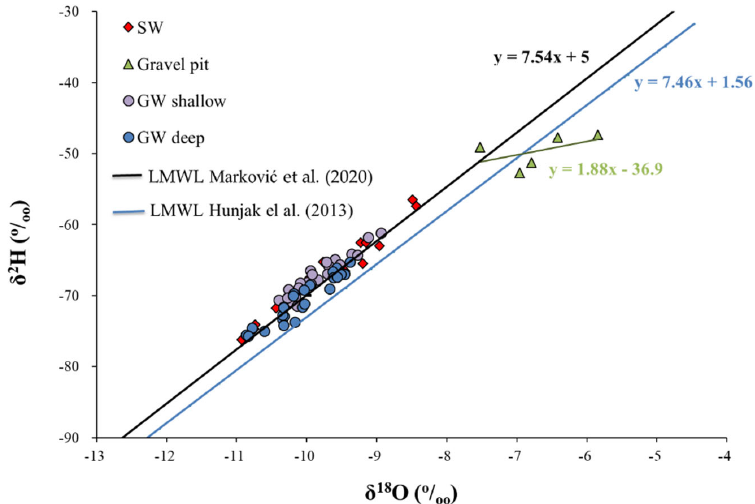
Figure 3. Distribution of GW and SW δ 18 O and δ 2 H values around the LMWLs Varaždin (modified after [19]) .